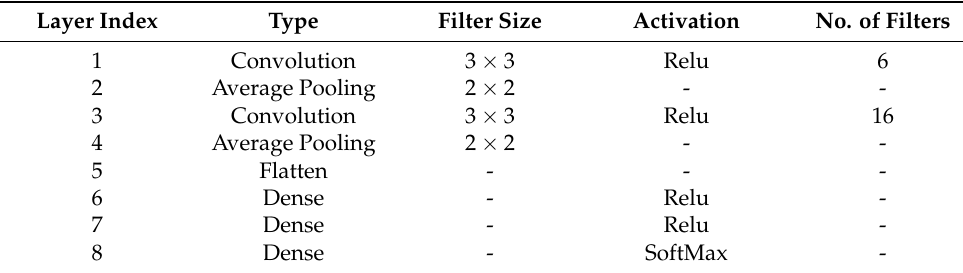
Figure 7. The architecture of LeNet5 model. Table 4. Adopted LeNet5